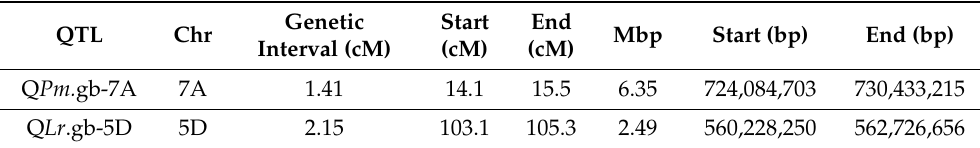
Table 5. Genetic and physical intervals identified for the major QTLs identified for powdery mildew and leaf rust